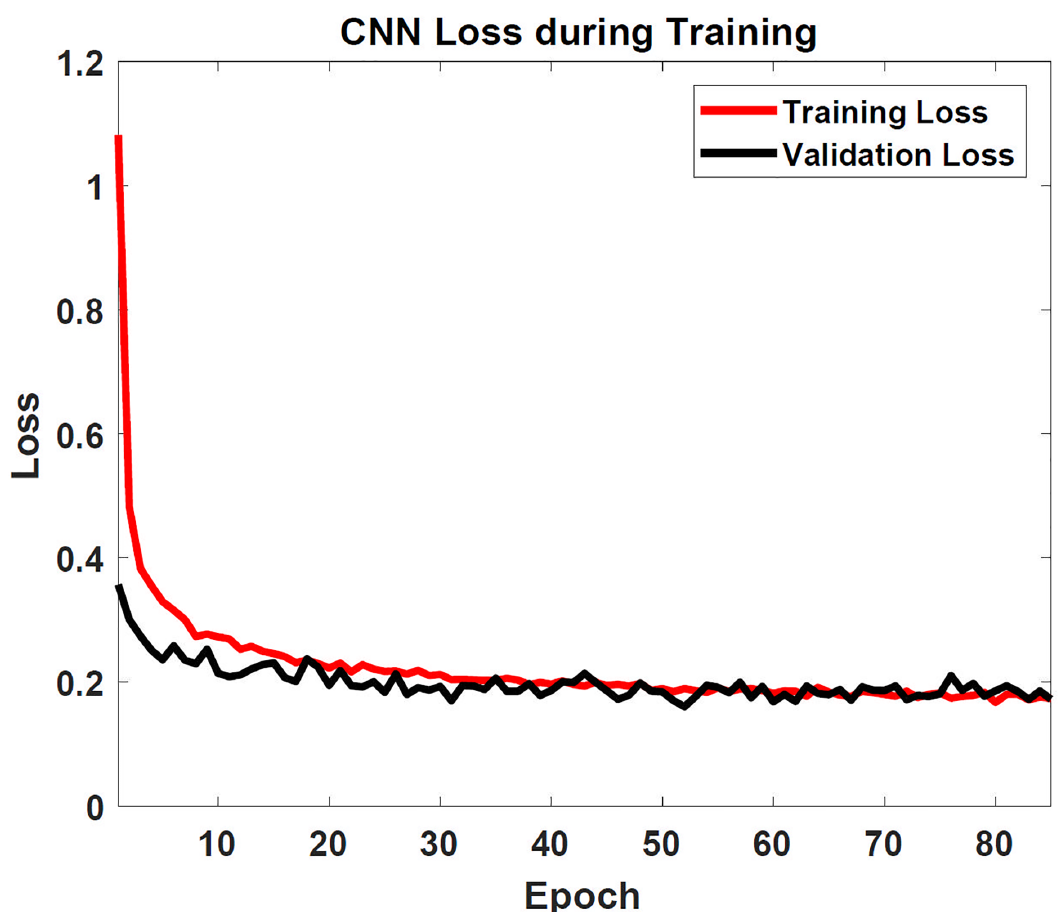
Fig 5. Convolutional neural network loss function. The categorical cross-entropy loss is shown for the convolutional neural network training as a function of the epoch number.